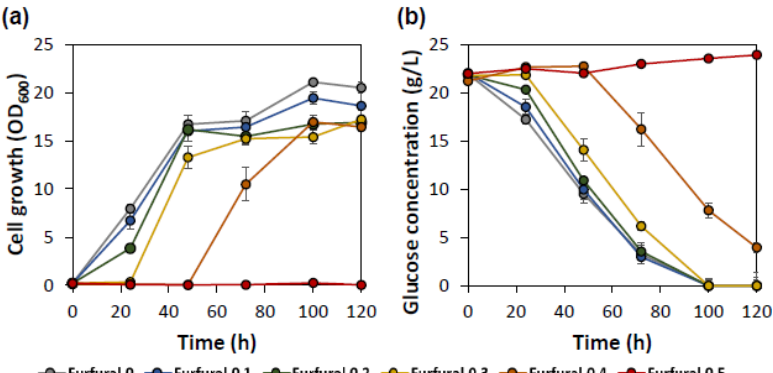
Figure 1. The inhibitory effect of furfural on the cell growth ( a ) and sugar consumption ( b ) of Y. lipolytica . Furfural was added to the CSM media at various concentrations of furfural (0–0.5 g/L). Error bars represent the standard deviation of biological triplicates.